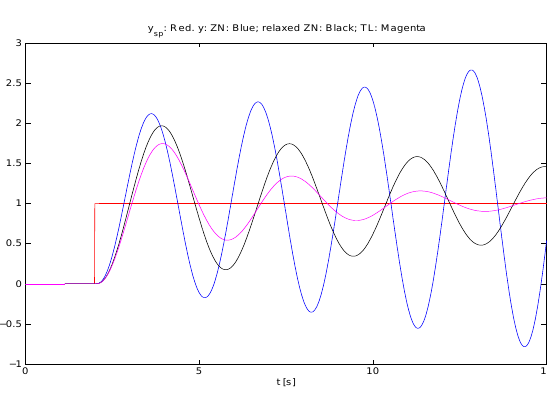
Figure 12: Responses with TL PI settings